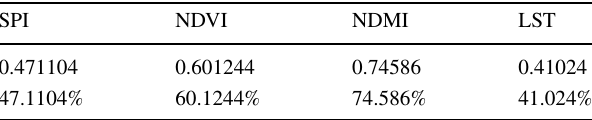
Table 4 Comparison of fire data correlation coefficient with fire risk zoning map from 2005 to 2020 Determining the correlation coefficient of the used indicators zoning with the fire